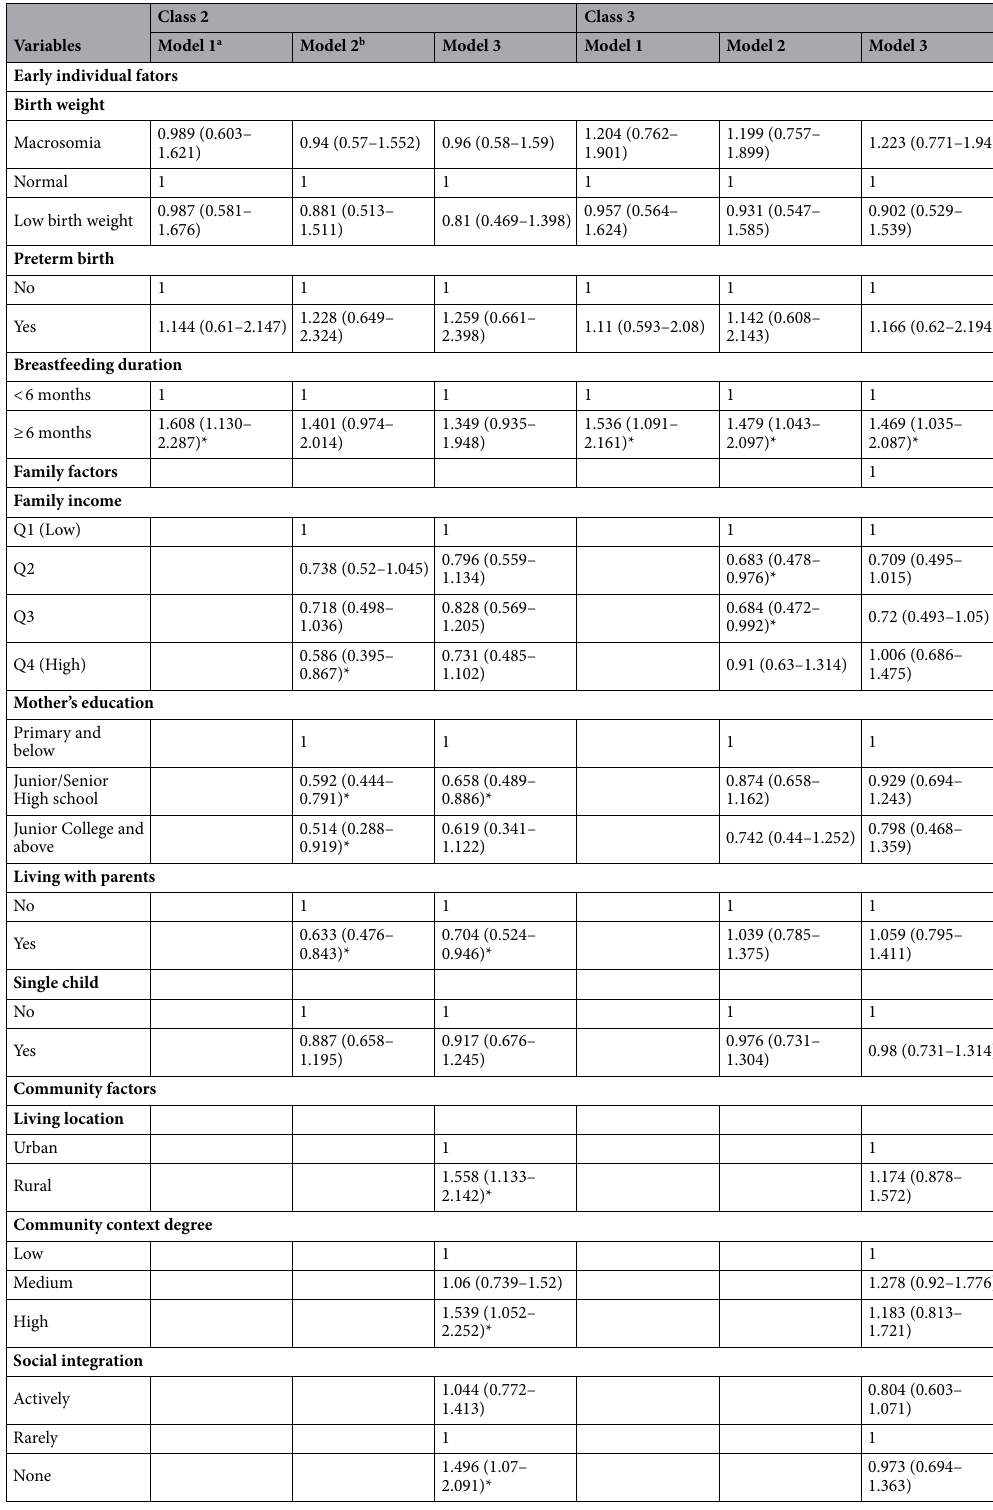
Table 6. Odds Ratios and 95% Confidence Intervals for early individual, family and community factors related to BMI z-scores trajectories membership among girls, CFPS. Class 1 was used as the reference